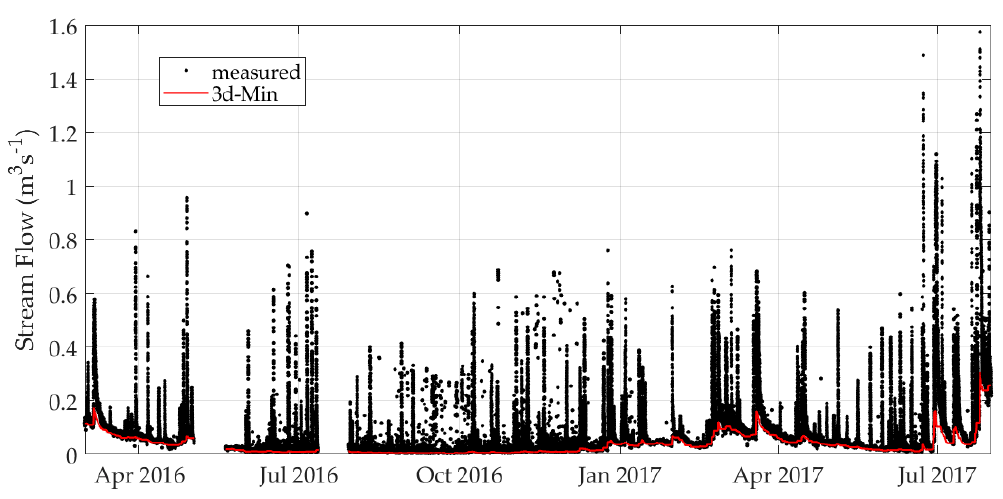
Figure 3. Measured stream flow and 3-day-minimum (sliding interval) to represent base flow at the monitoring station “Autobahn” (AB).